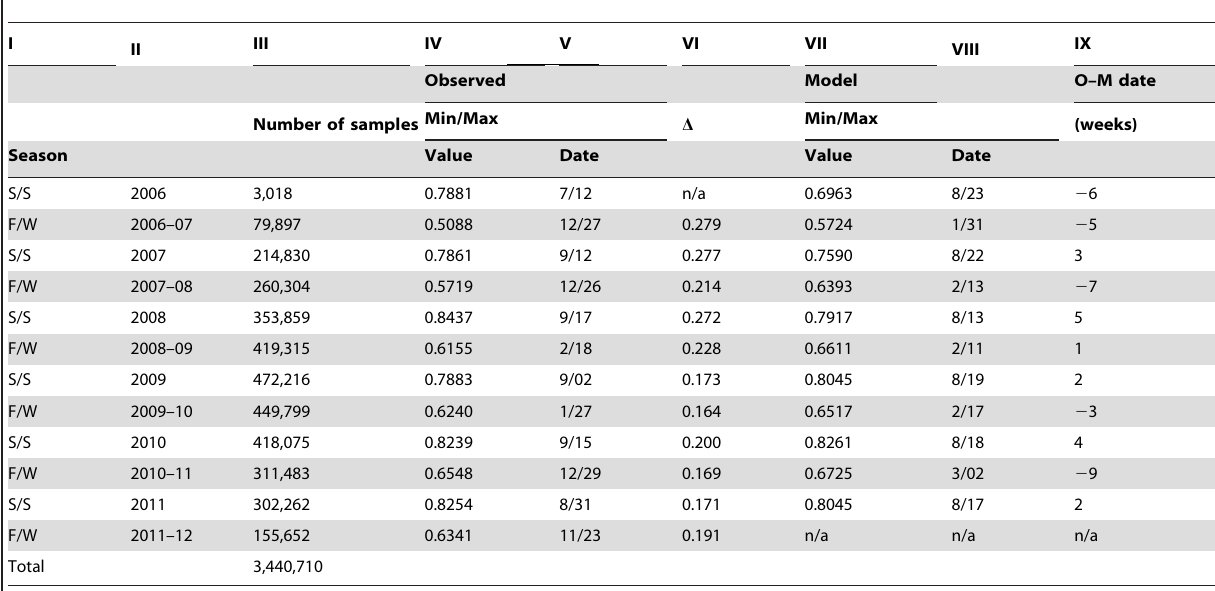
Table 2. Season-by-season summary of 25OHD peaks and troughs.